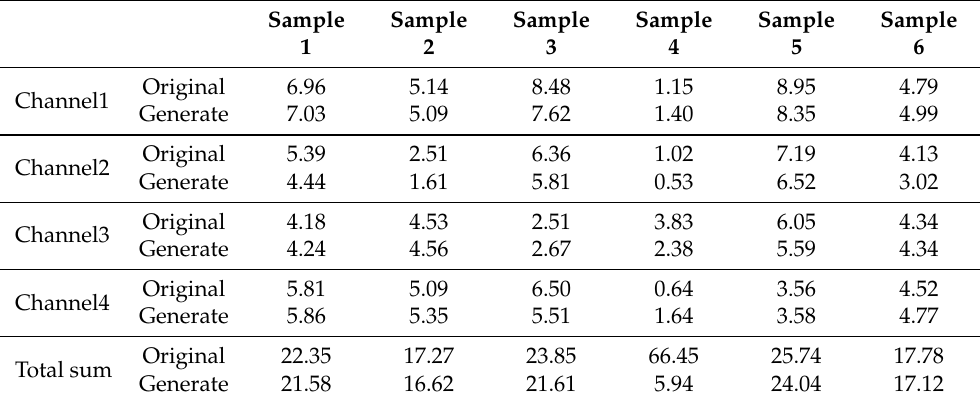
Table 3. A comparison of F-norms between the generated halftone images and the original halftone images () × 10 3